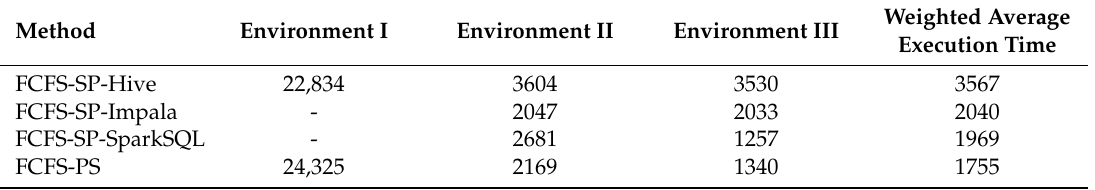
Table 9. Performance comparison among the methods for Case 1 (unit: s).